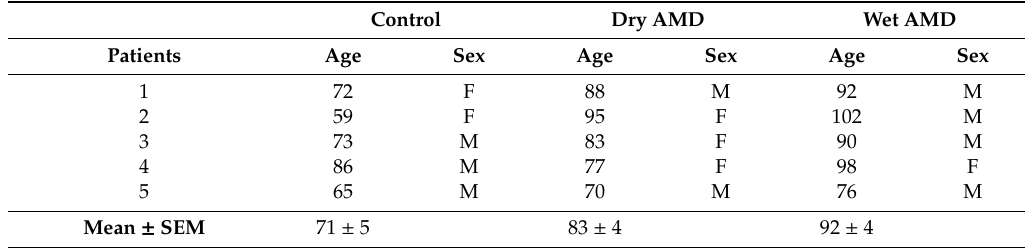
Table 1. Characteristics of retinae donors.